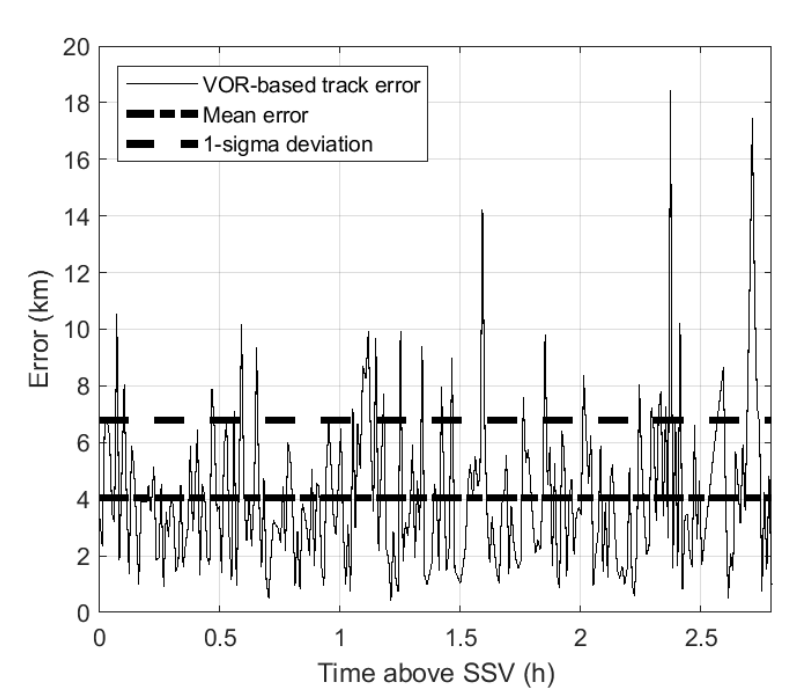
Figure 7. Error between the VOR-based track and the GPS data.